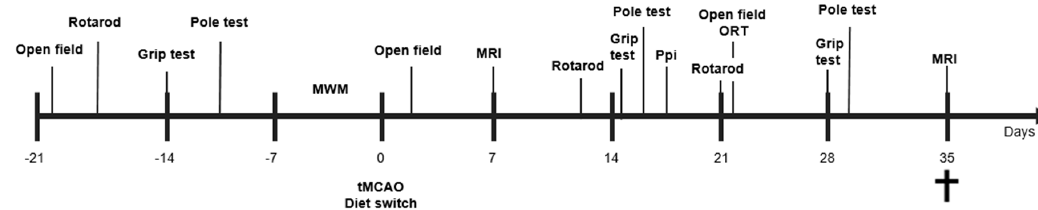
Figure 1. Study design. After a transient occlusion of the middle cerebral artery (tMCAo) for 30